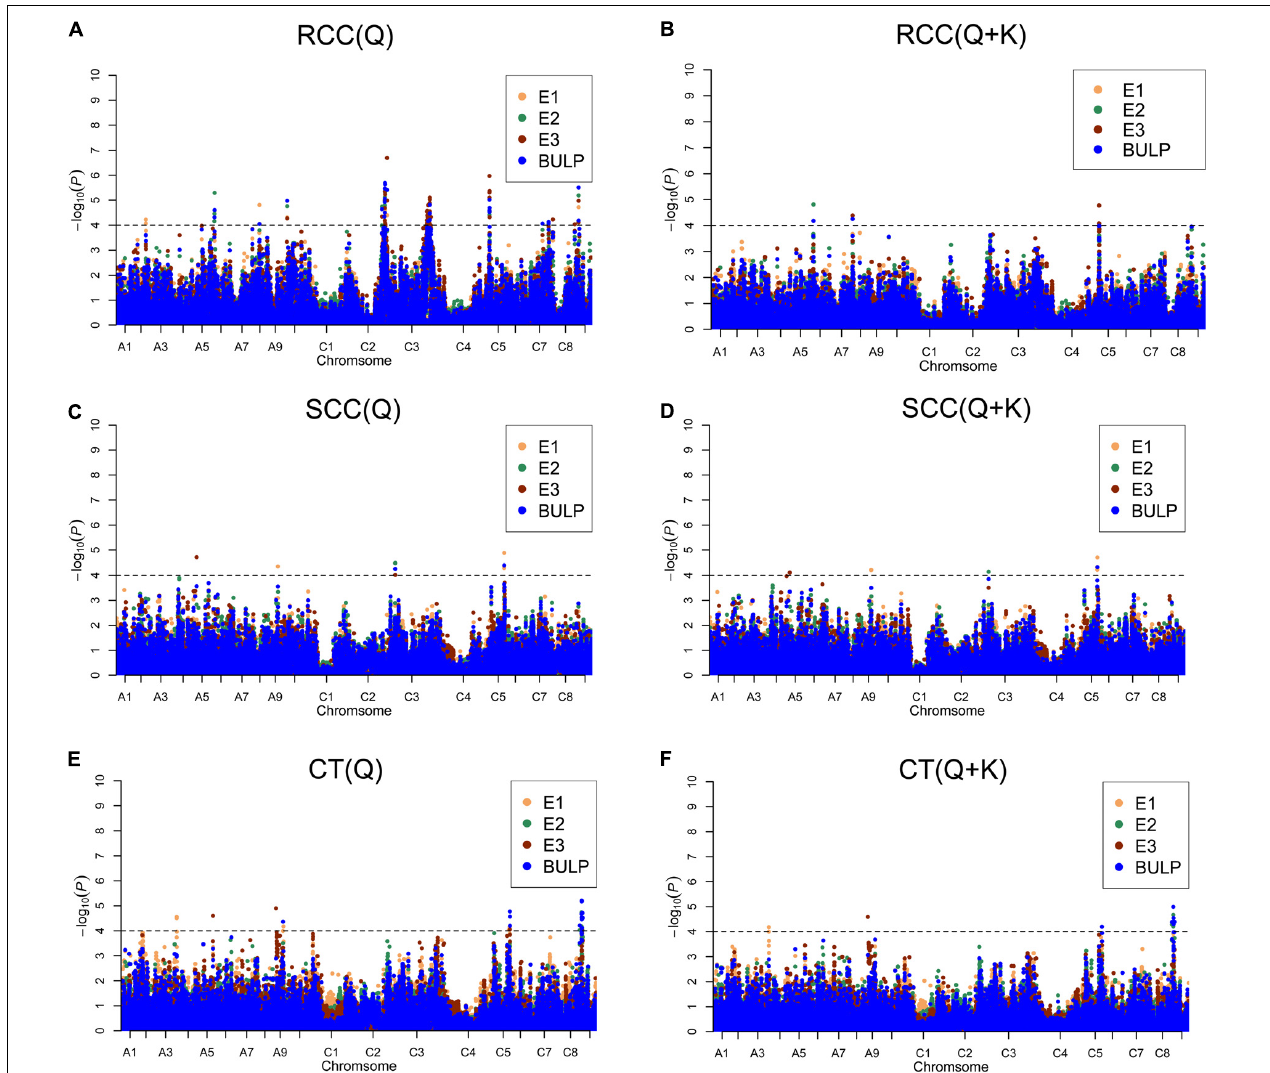
FIGURE 3 | Manhattan plots generated from genome-wide association analysis results for Cd accumulation traits using Q and Q + K models. (A) RCC (Q). (B) RCC (Q + K). (C) SCC (Q). (D) SCC (Q + K). (E) CT (Q). (F) CT (Q + K). E1, greenhouse in 2013; E2, greenhouse in 2014; E3, natural environment condition in 2014; BLUP, best linear unbiased prediction values. Gray horizontal line depicts significantly threshold ( P <